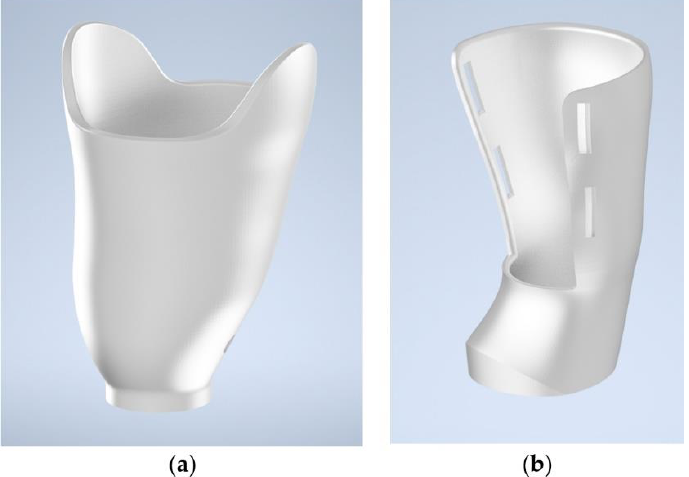
Figure 5. Automatically designed sockets for a customized prosthesis. ( a ) Vacuum socket (VAC) and ( b ) open socket (VEL).